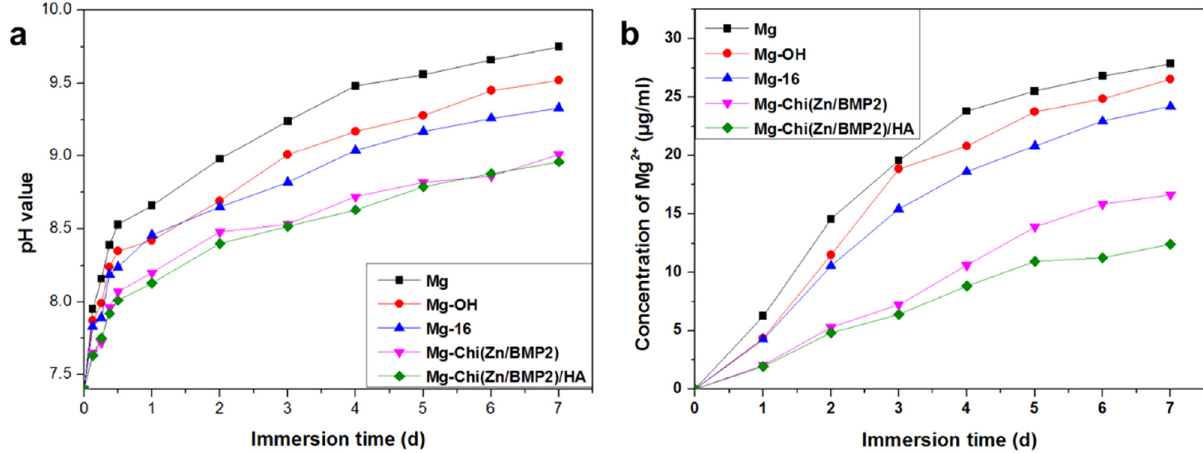
Figure 4: The degradable behaviors of the di ff erent samples characterized by pH changes and Mg 2 + release concentrations of the